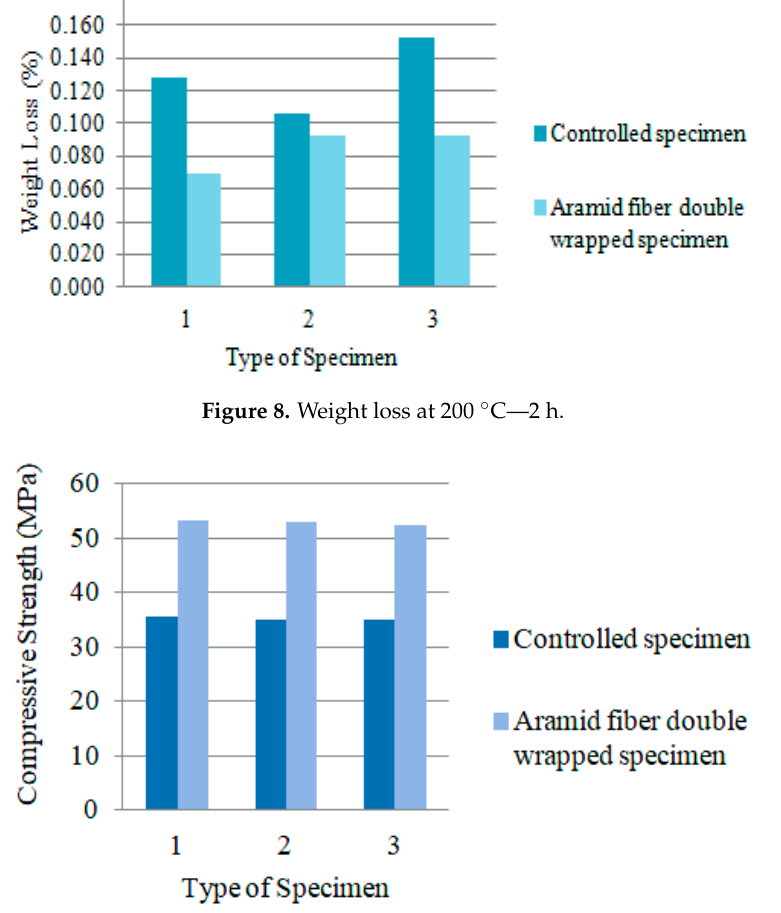
Figure 9. Compressive strength at 200 °C—2 h.